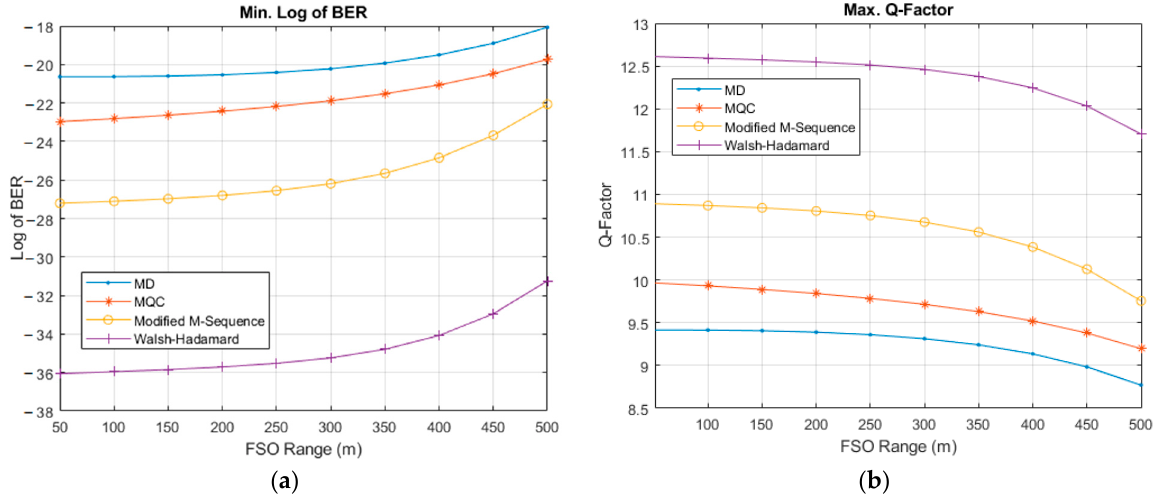
Figure 12. Performance of the system in intense rainy weather condition for AWGN and turbulence-induced fading channel: ( a ). min. log of BER; ( b ). max. Q ‐ factor.